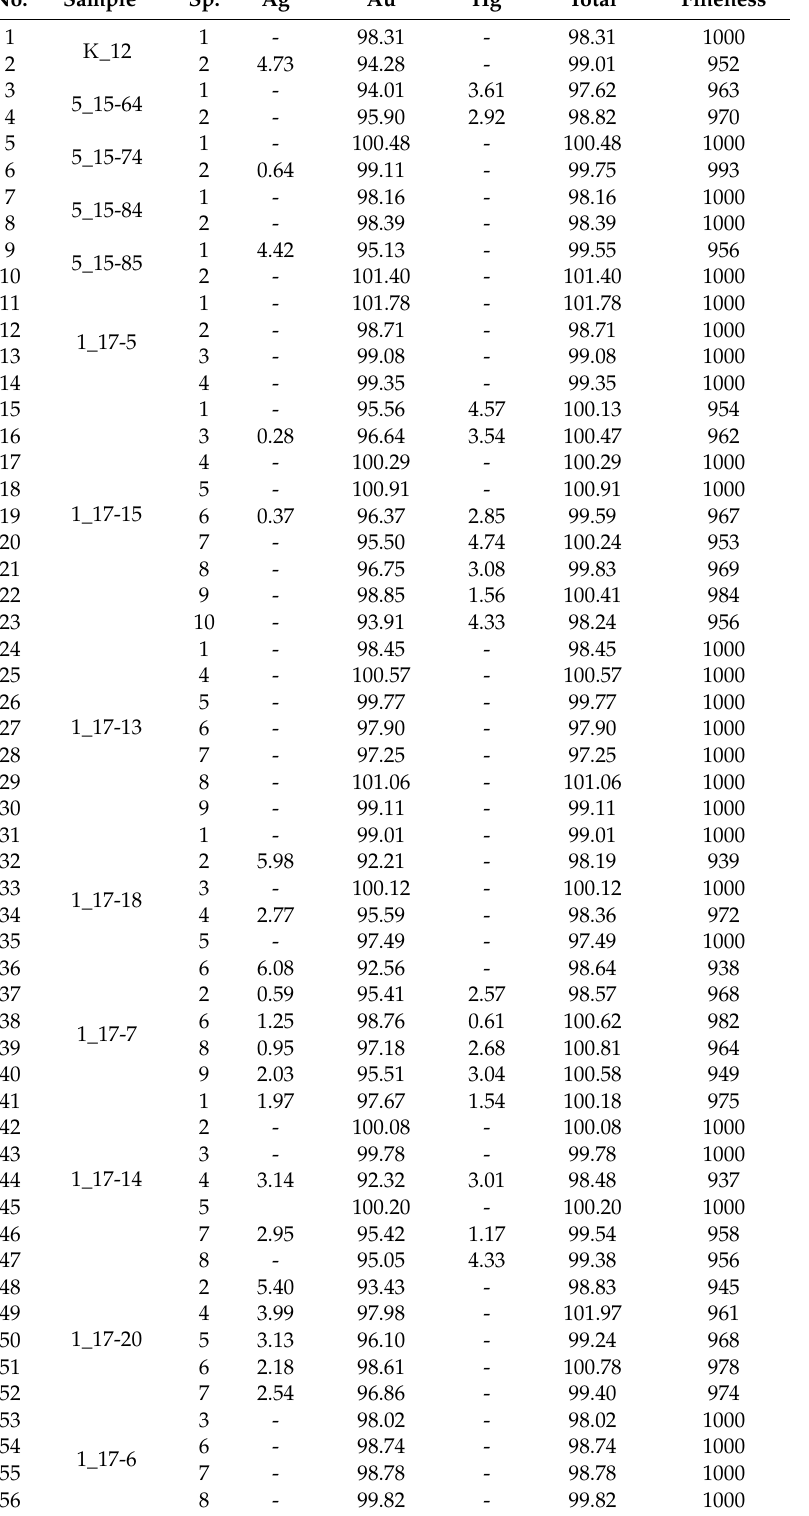
Table 2. The composition (in wt%) and fineness (in % (cid:24) ) of the supergene gold shown in Figures 3, 4, 8 and